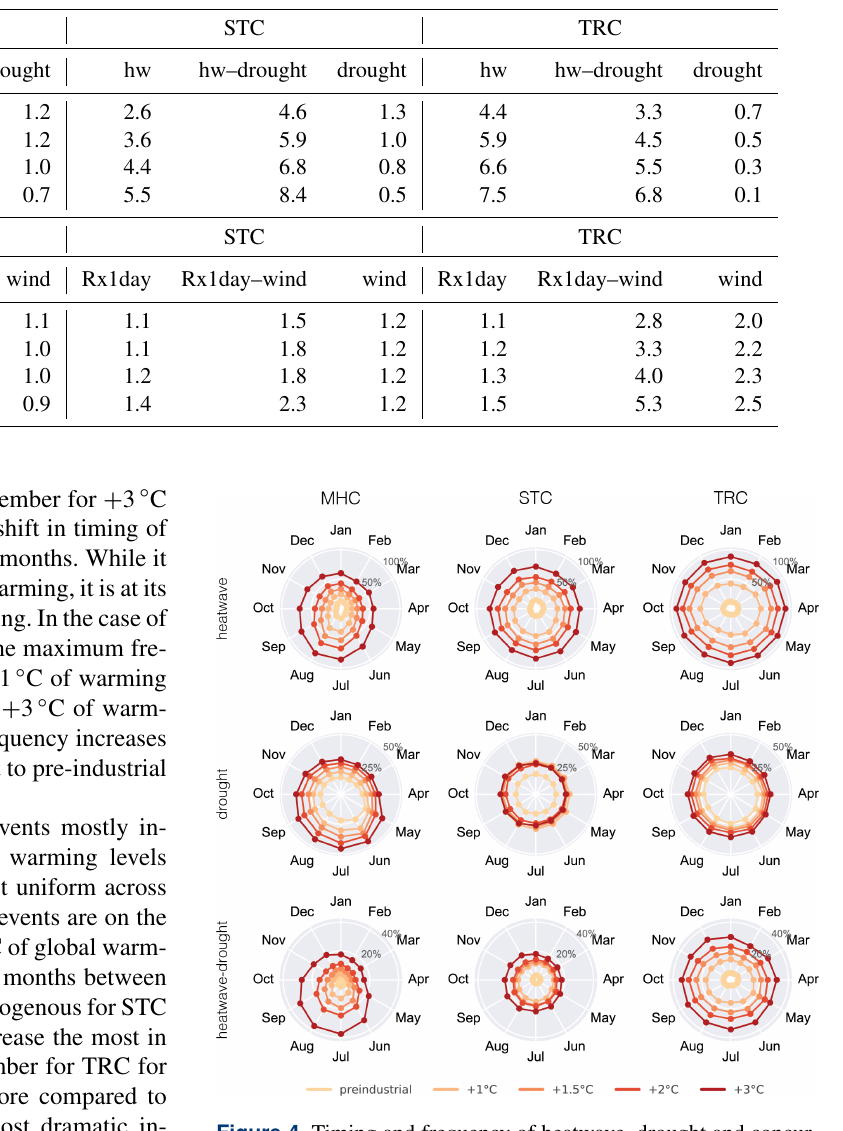
Figure 4. Timing and frequency of heatwave, drought and concur- rent heatwave–drought events in MHC, STC and TRC at the pre- industrial period and at + 1, + 1.5, + 2 and + 3 ◦ C global warming levels in